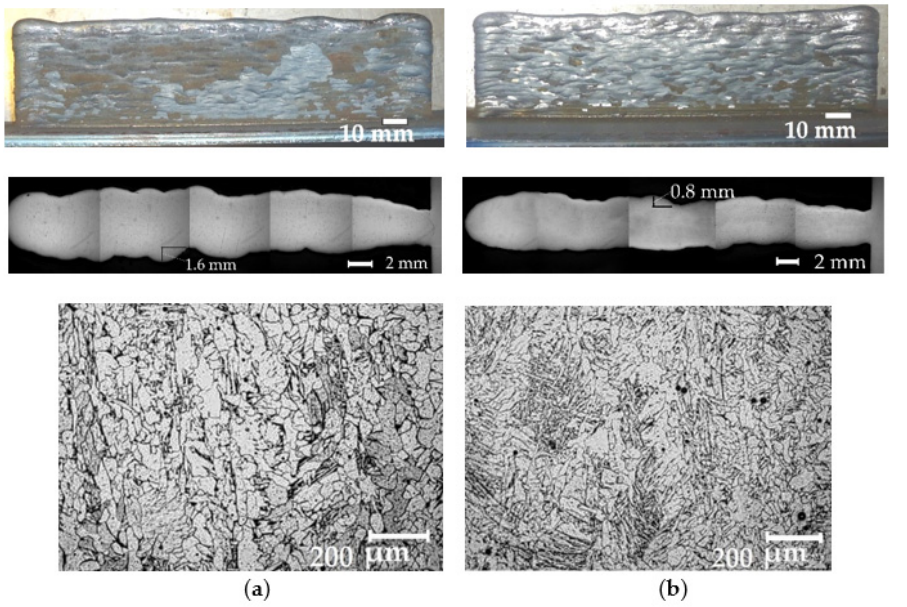
Figure 16. Formation, macrostructure and microstructure of a vertical specimen cross-section with G3Si1 wire of 1.2 mm: ( a ) uncoated wire, specimen thickness is 6 mm, layer thickness is 2–2.2 mm; ( b ) wire with Ni-LaF 3 composite coating, specimen thickness is 5 mm, layer thickness is 1.5–2 mm.